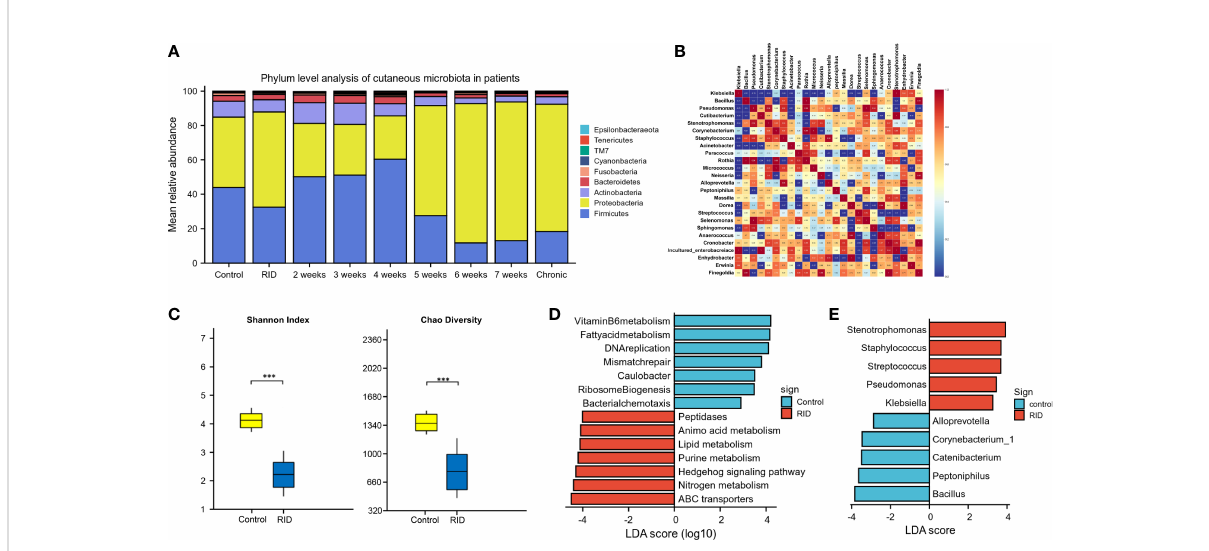
FIGURE 6 Alterations in patients with radiotherapy-induced dermatitis. (A) Changes in the microbial structure of patients with radiation-induced dermatitis (RID) with different prognosis. (B) Heatmap of the correlation coef fi cients. (C) Change of species diversity. (D) Differential metabolic pathways. (E) Linear discriminant analysis effect size (LEfSe) in patients with radiation-induced skin injury (RISI) compared with healthy subjects. *p < 0.05; **p < 0.01; ***p <